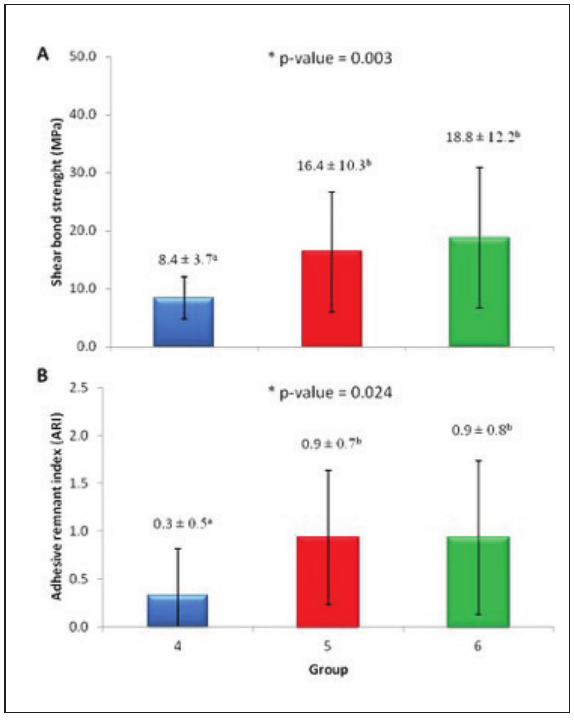
Figure 2. Comparison of shear bond strength (A) and ARI (B) between groups. Columns represent means, and error bars the standard